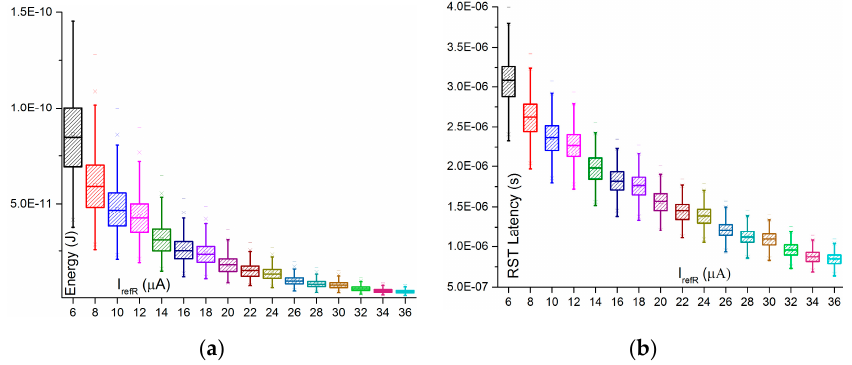
Figure 13. ( a ) Energy/cell and ( b ) RST latency box plots obtained after 500 MC simulation performed for RST compliance currents ranging from 6 μ A to 36 μ A (4 bits/cell).